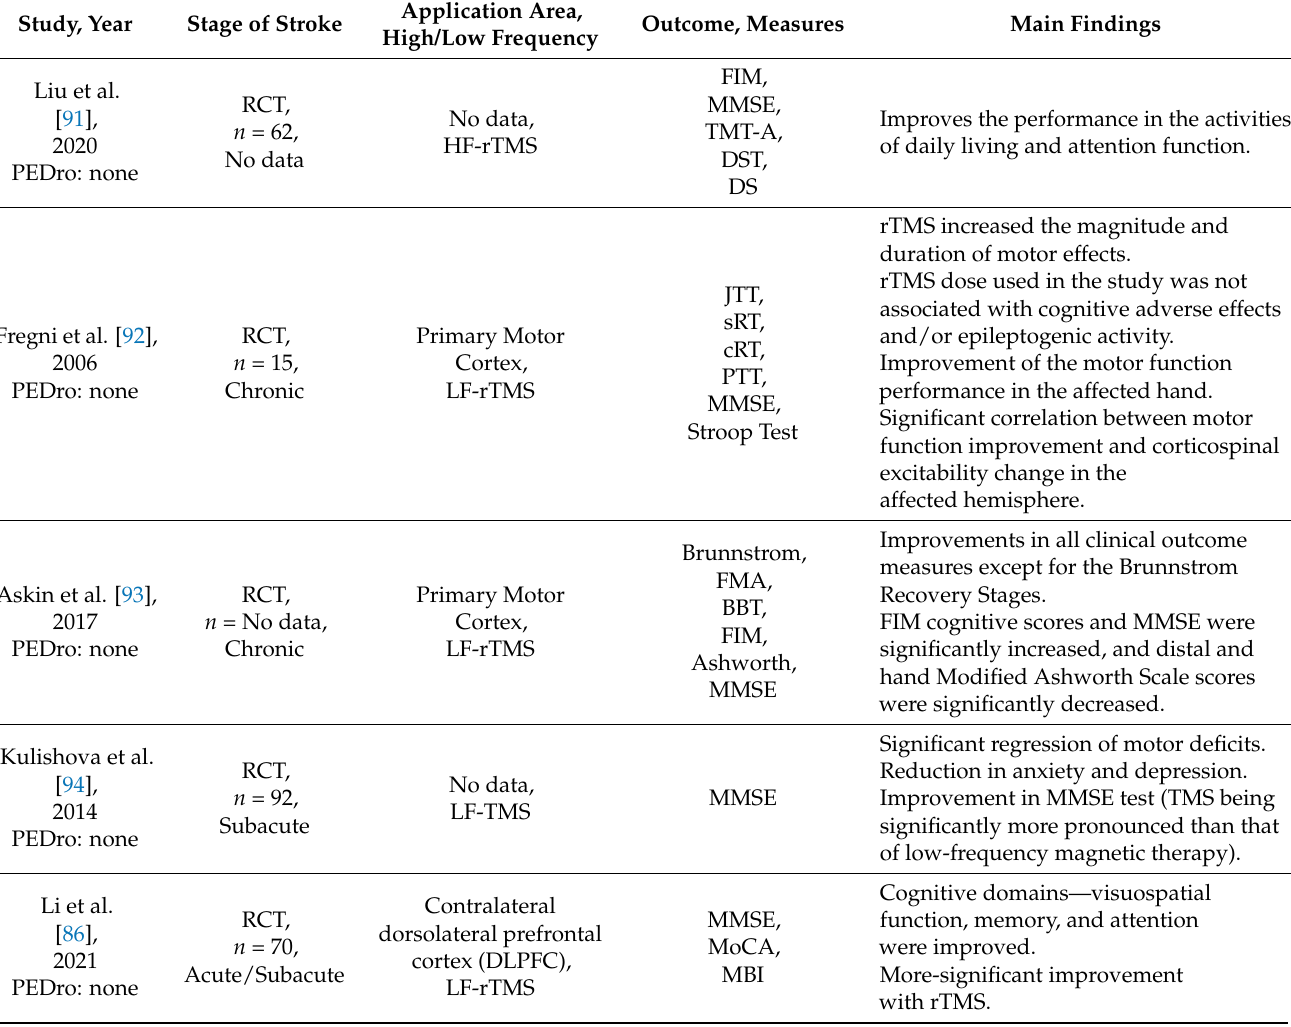
Table 2. Summary of potential benefits in cognitive functioning after using TMS therapy in stroke patients in RCTs with a valid measure of the methodological quality of clinical trials using the PEDro